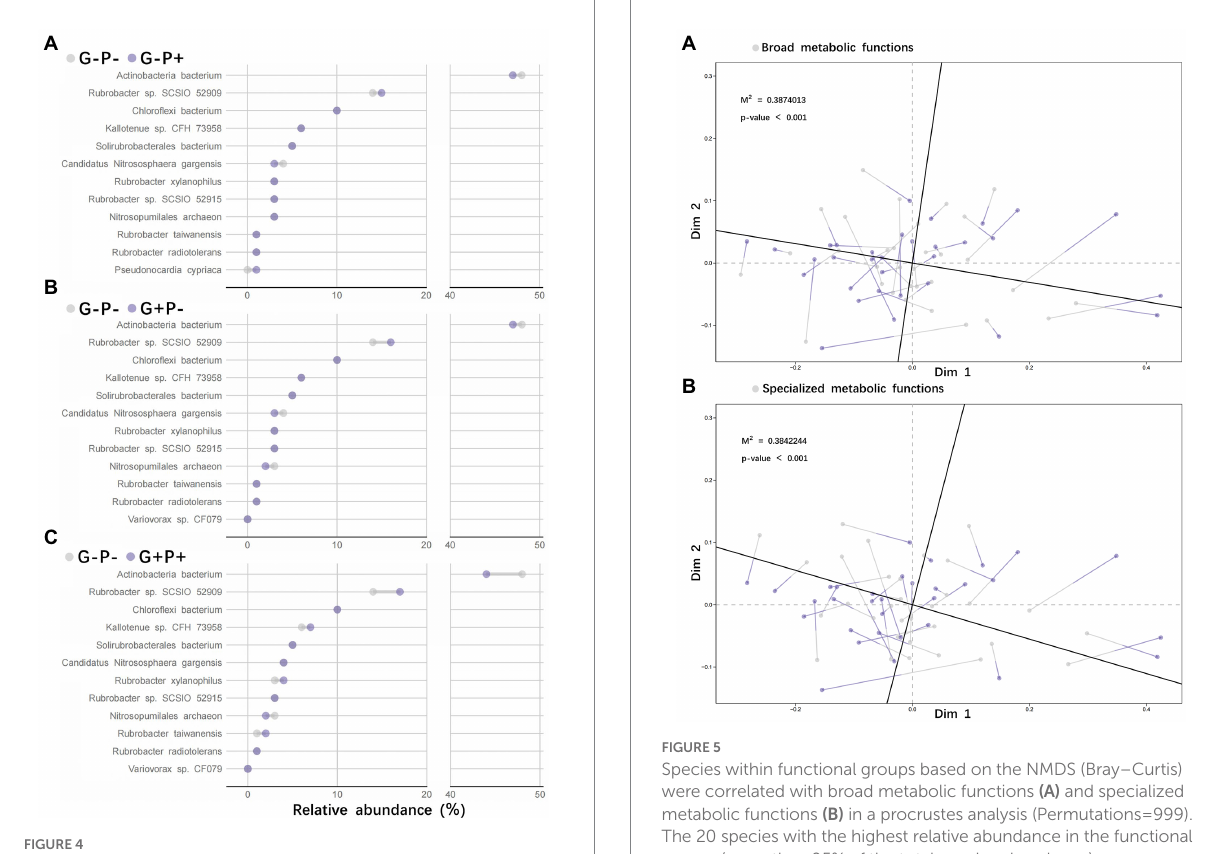
FIGURE 4 The variation trend of species relative abundance within functional groups between no-grazing and no-P addition control (G–P–) and other three treatments of P addition only ( A : G–P+), grazing only ( B : G + P–), and both P addition and grazing ( C : G + P+). The top 12 species with the highest relative abundance in the functional groups (more than 95% of the total species abundance) were selected, and their metabolic functional gene abundance was also the highest both in broad and specialized functions.